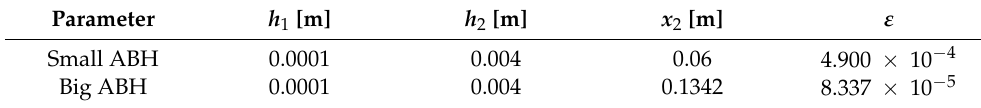
Table 1. Geometrical parameters of the two-dimensional ABHs in the simulation.